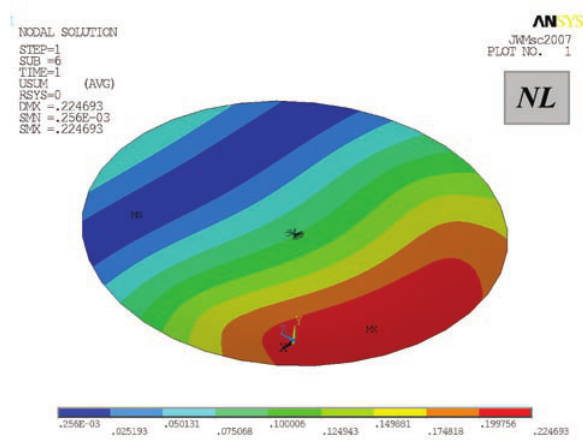
Fig. 12. Plate deflections (linear analysis), m Fig. 12a. Plate deflections (nonlinear analysis),